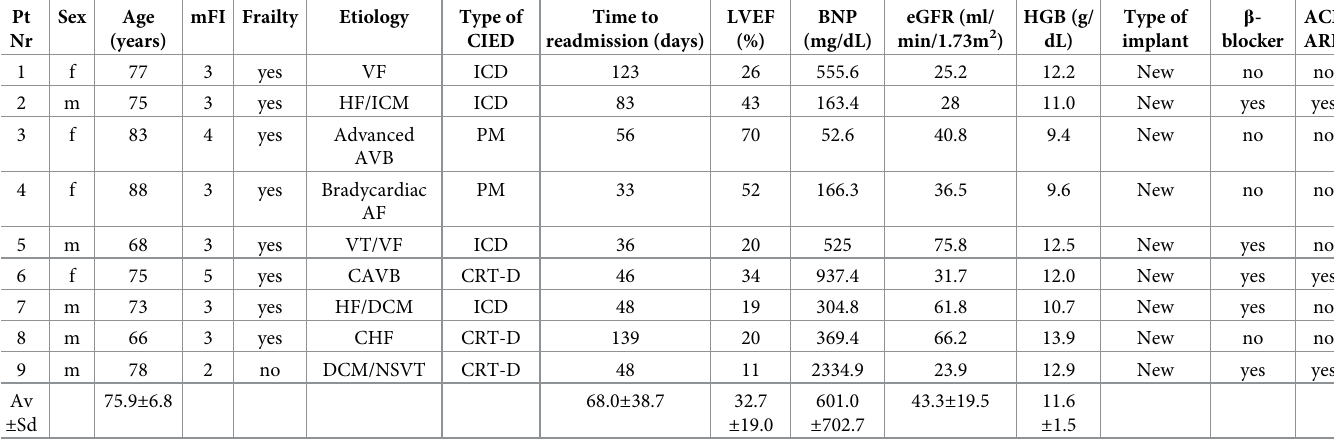
Table 2. Characteristics of participants who were readmitted.